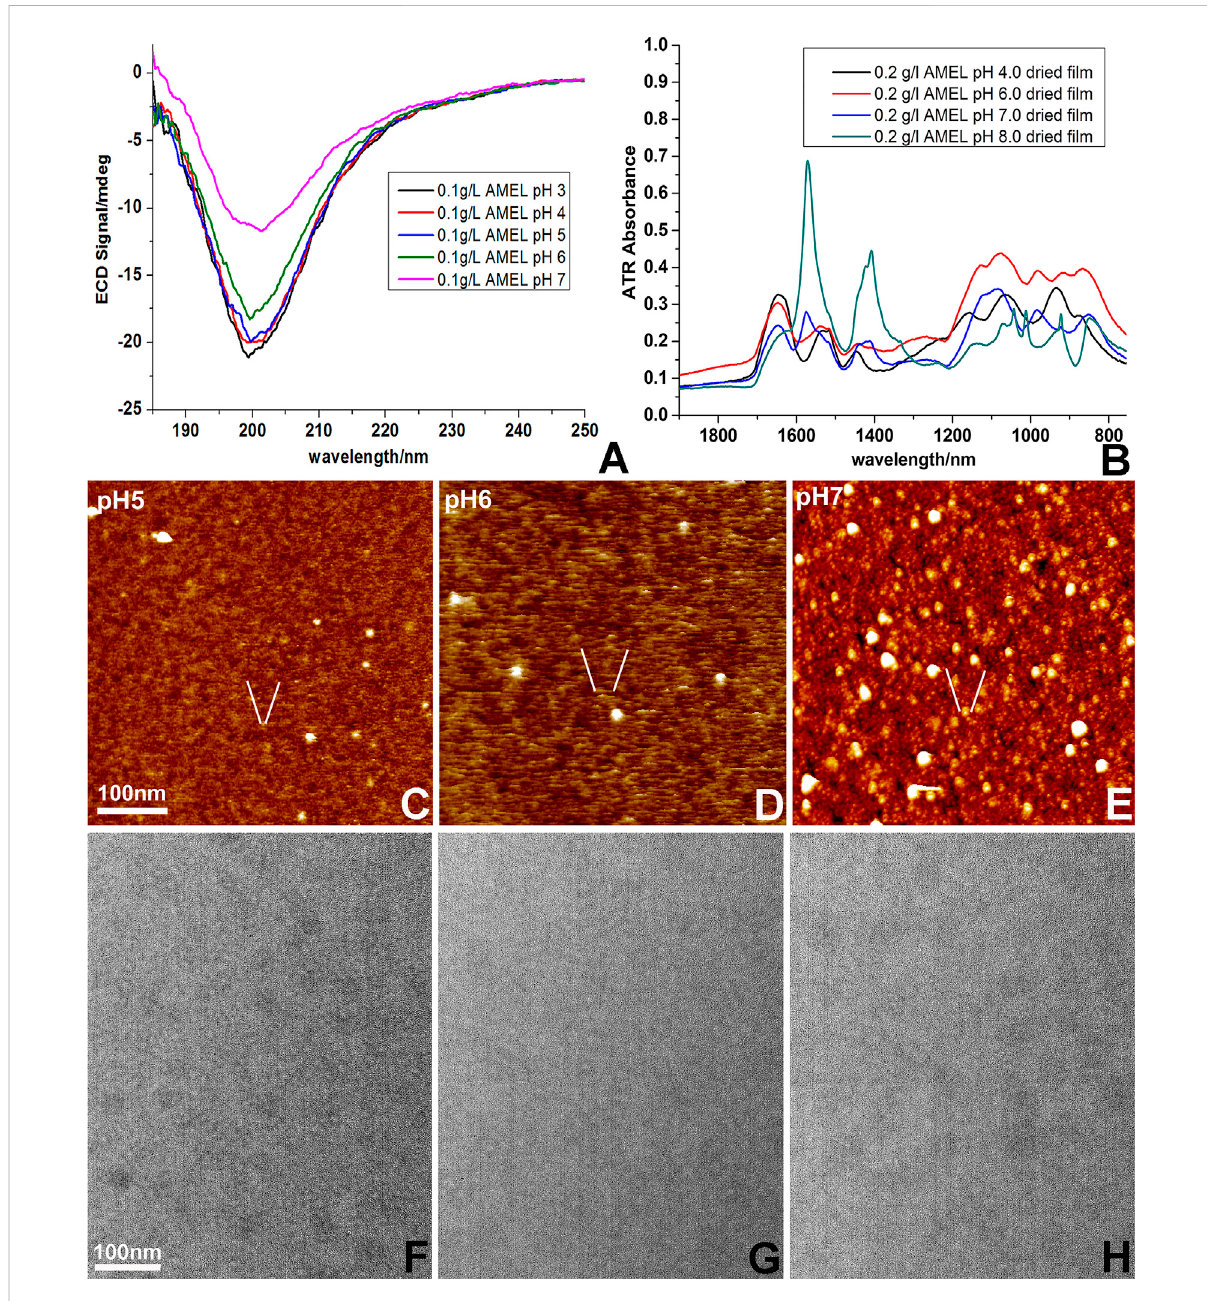
detected in the N92 spectrum while they were recognized in the TRAP spectrum (Figure 3B vs. Figure 3D), suggesting that interactions only occured in the full-length amelogenin and not in between individual amelogenin